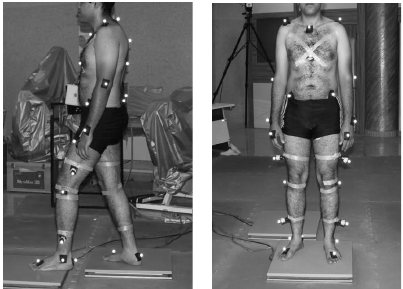
Figure 2. Body-mounted motion capture including 37